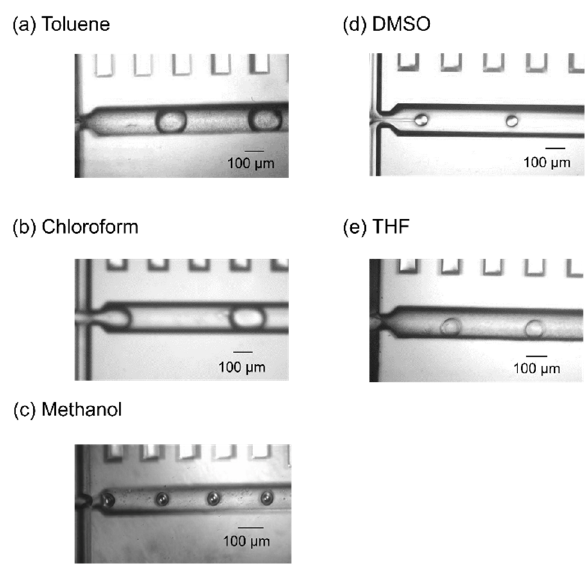
Figure 1. Images showing the microfluidic flow at the cross-junction area for ( a ) toluene, ( b ) chloroform, ( c ) methanol, ( d ) dimethyl sulfoxide (DMSO), and ( e ) tetrahydrofuran (THF). The flow rates of the dispersed and continuous phases (µL/min) were ( a ) 1 and 3, ( b ) 1 and 3, ( c ) 0.3 and 3, ( d ) 0.4 and 8, and ( e ) 0.5 and 5, respectively. The magnification of microscope was 10×.